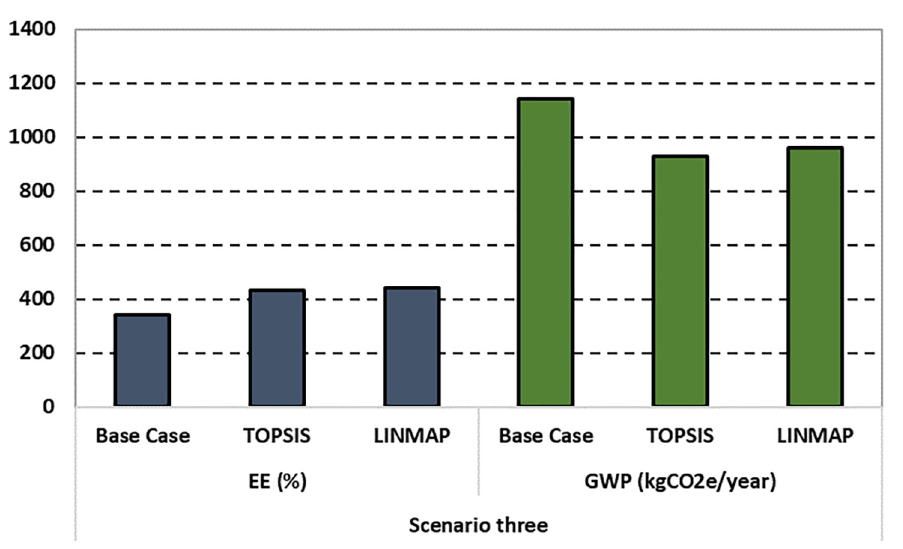
Fig 10. Comparison of EE and GWP for the third